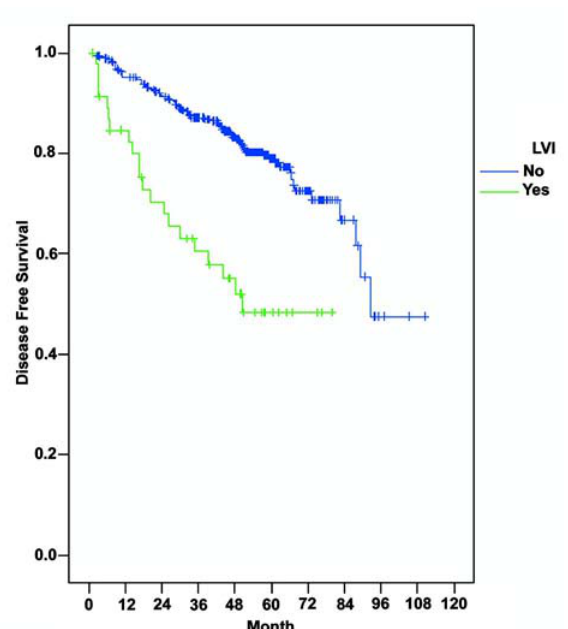
Figure 1 – Biochemical recurrence according to microvascular invasion (log-rank: p <